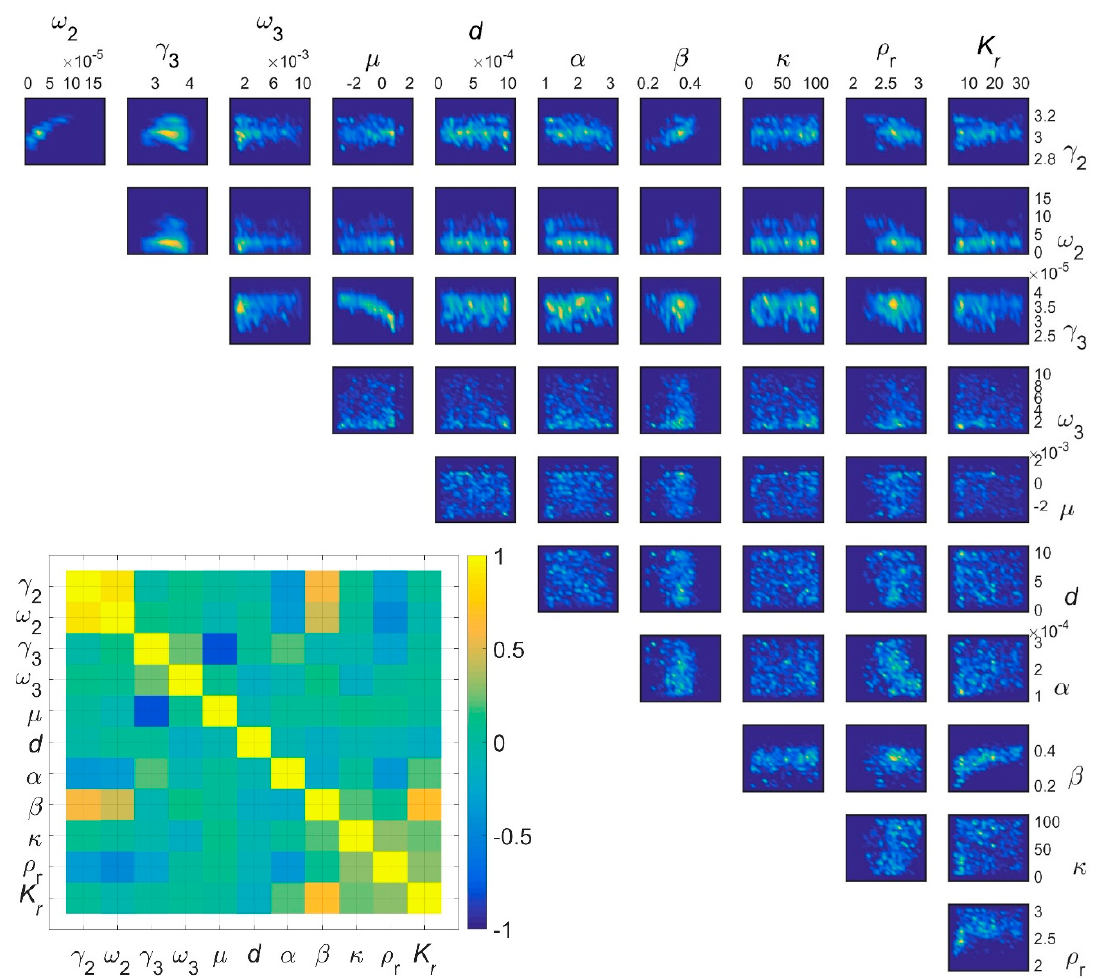
Figure 5. Estimates of two-dimensional marginal PPDs for fluid model parameters ( top right ) and correlation matrix map ( bottom left ).